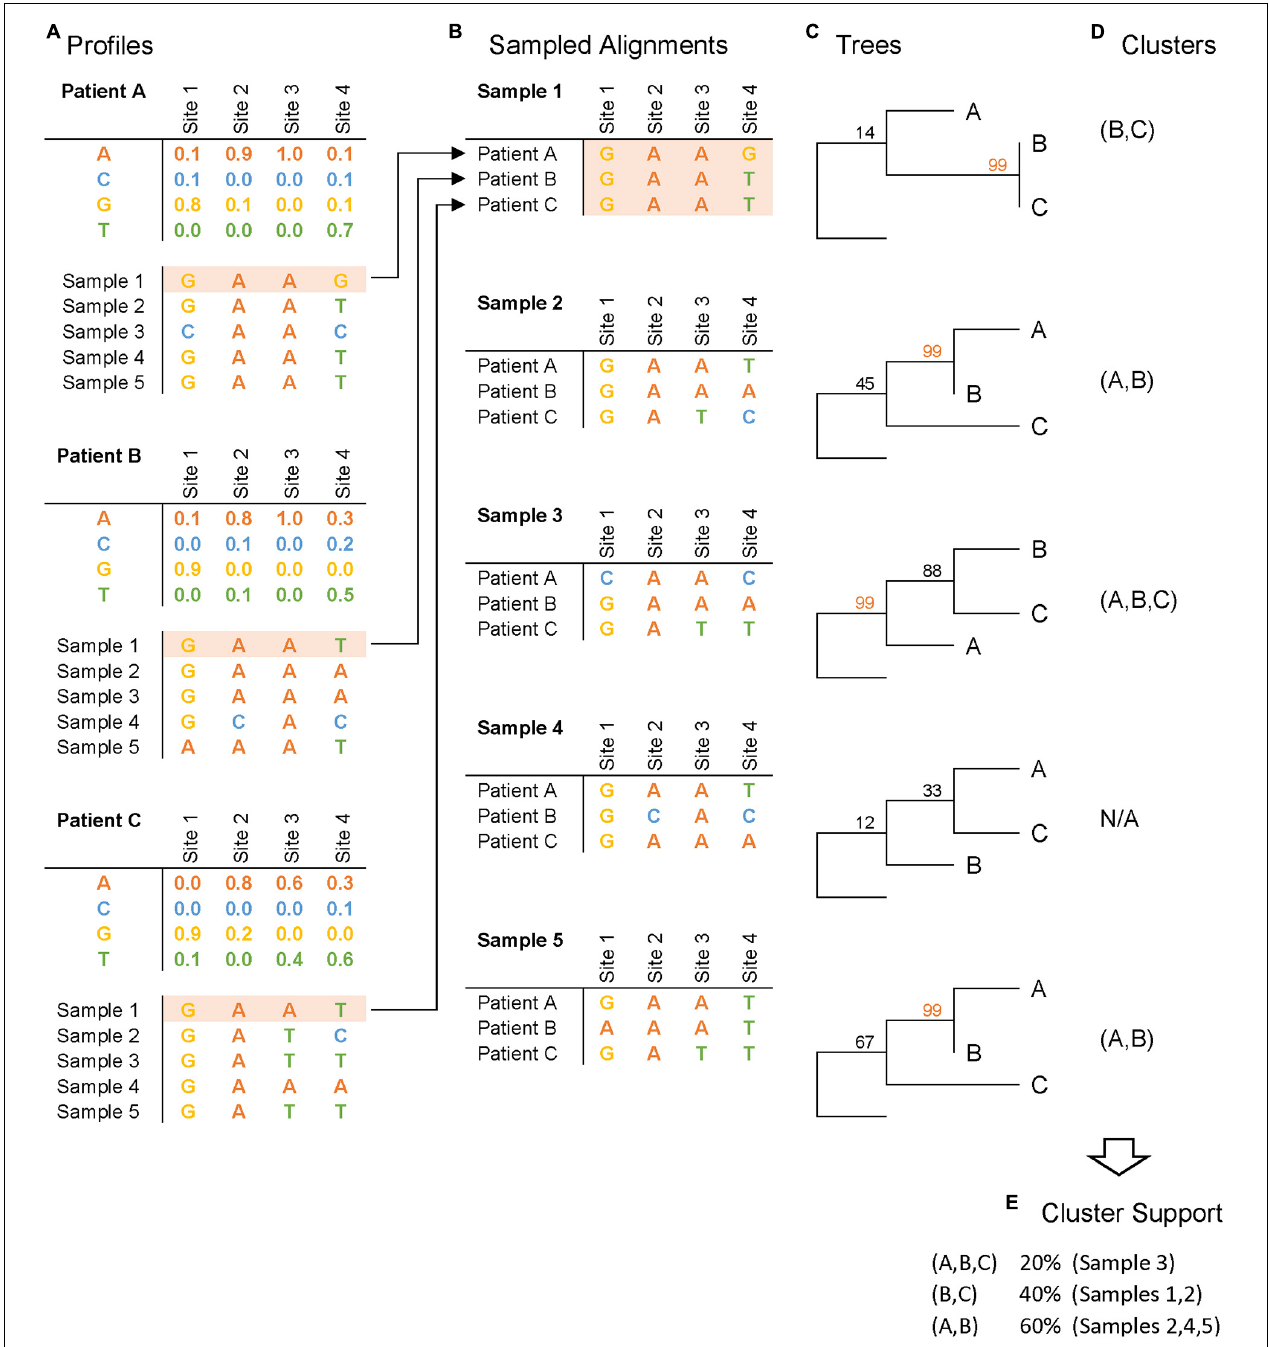
FIGURE 1 | Profile sampling pipeline. This schematic figure depicts the four steps of the profile sampling process, illustrated here with 5 samples per patient: (A) NGS-derived frequencies at each HIV genome site for each patient are generated, and synthetic sequences are sampled from these frequency tables to summarize intra-host variation; (B) sampled sequences are collated across patients to construct sampled alignments; (C) phylogenetic trees are inferred with bootstrap support from the alignments; (D) clusters are inferred based on phylogenetic bootstrap support (illustrated here with bootstrap support ≥ 99); and (E) cluster support is measured as the frequency that a cluster is inferred across